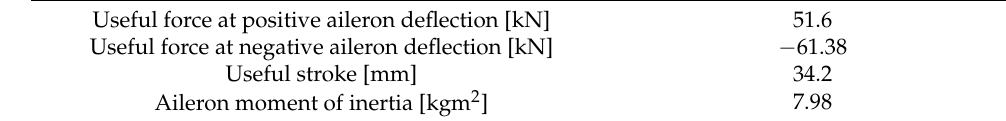
Table 1. Estimated electro-hydrostatic